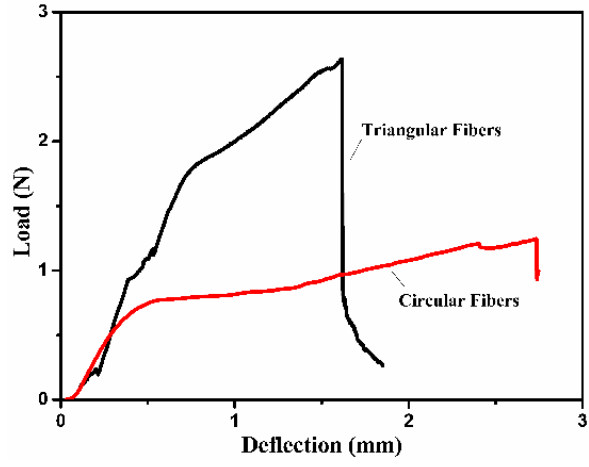
Figure 10. The load–deflection curves of PVA triangular fibers and circular fibers.